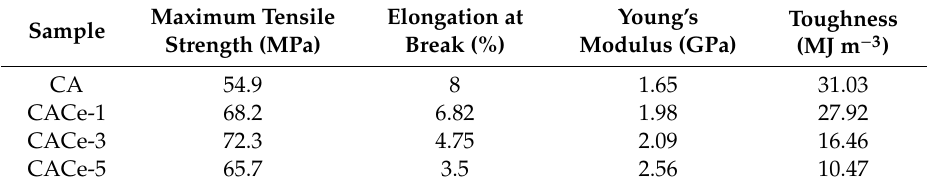
Figure 8. Thermogravimetric analysis (TGA) thermograms for CACe, CACe-1 and CACe-5 samples.